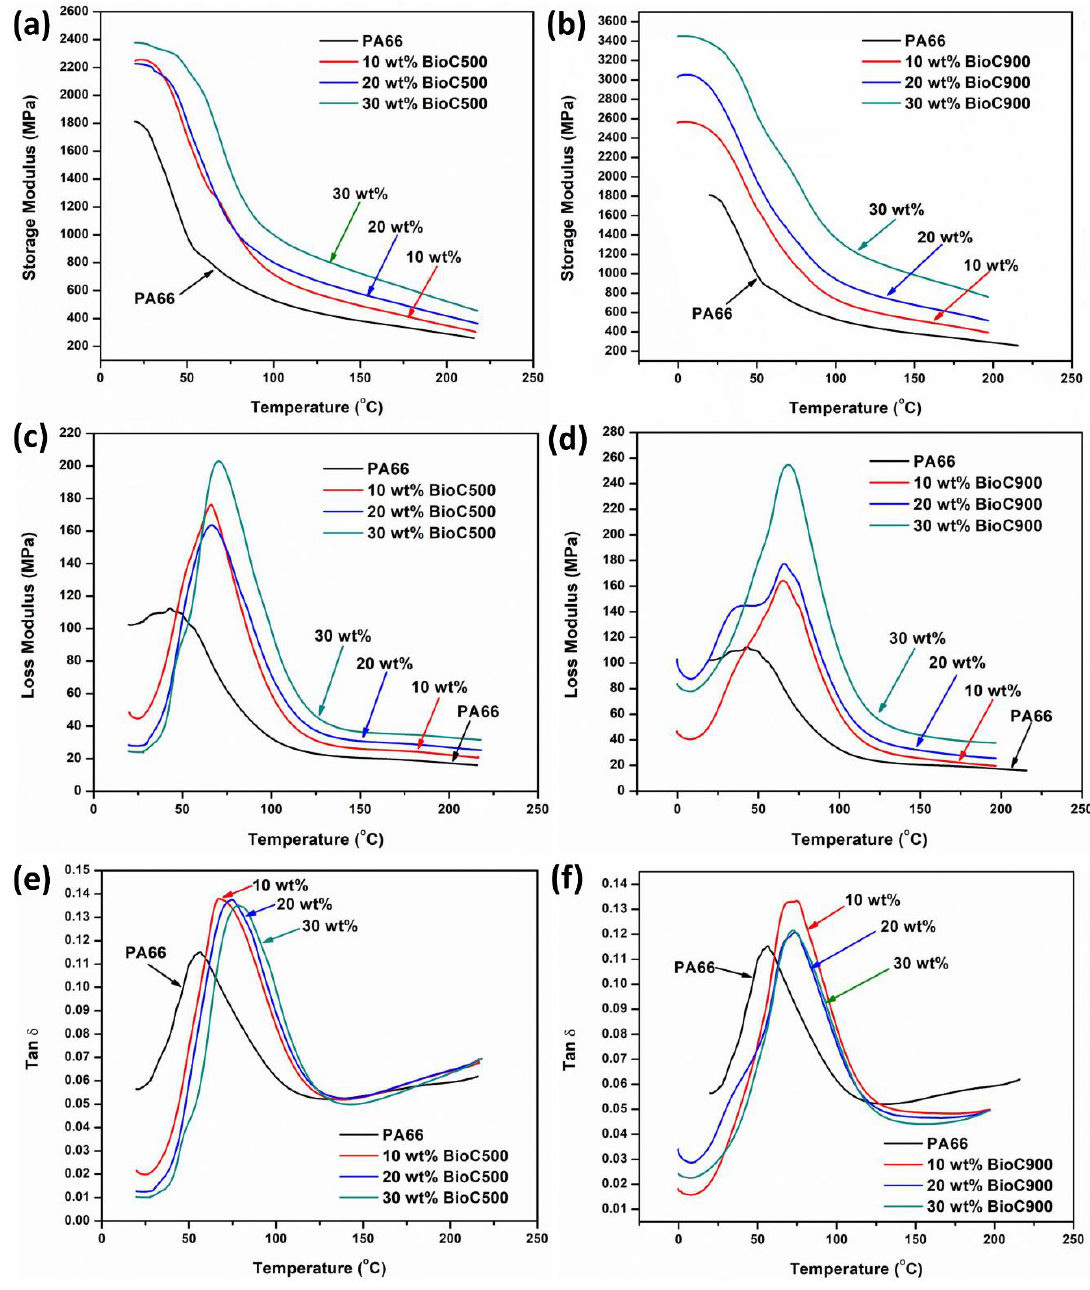
Figure 7. DMA curves of PA66 and its biocomposites with low and high pyrolysis temperature BioC at different weight contents ( a ) storage modulus, ( c ) loss modulus, ( e ) Tan δ of BioC500/PA66, and ( b ) storage modulus, ( d ) loss modulus, and ( f ) Tan δ of BioC900/PA66.